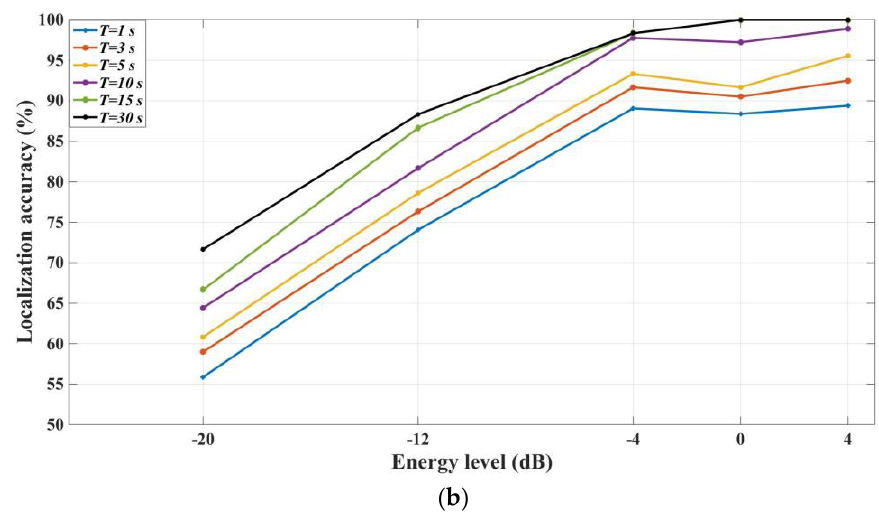
Figure 8. Impact of power level on localization accuracy: ( a ) p - RSSI index; ( b ) m - RSSI index.